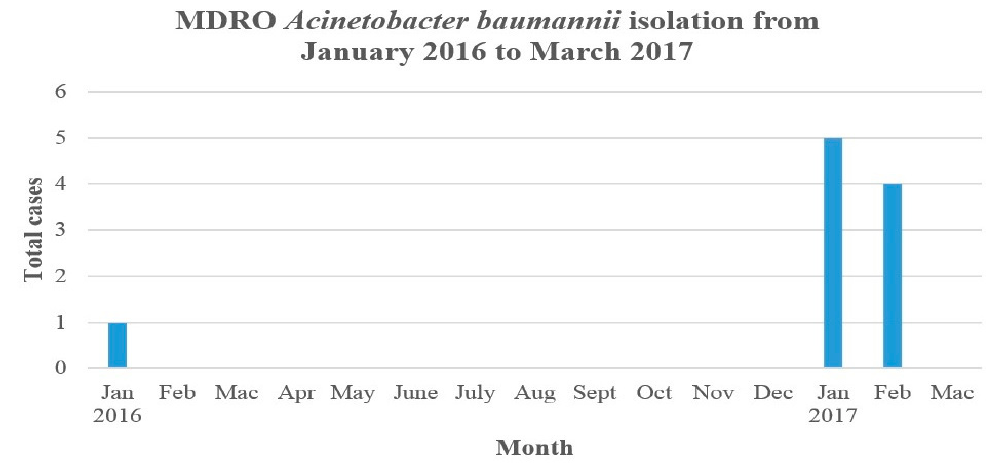
Figure 1. Isolation of multidrug-resistant Acinetobacter baumannii in the NICU from January 2016 to March 2017.